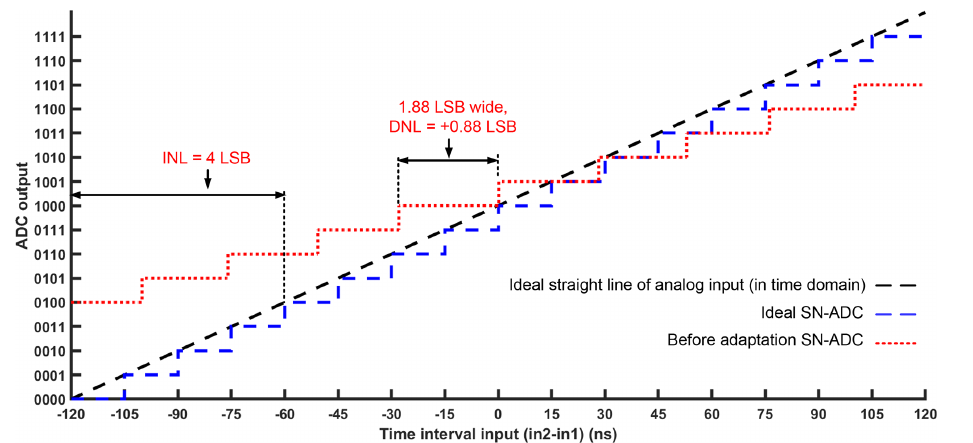
Figure 16. The transfer function of SN-ADC for both ideal and before adaptation at corner no. 5 in Table 3, at the following circuit conditions: V dd is 3V, temperature is 85 ◦ C, and the process corner is the WO (worst-case one). Before adaptation, the SN-ADC parameters NOMC, DNL, and INL are six missing codes, i.e., 0.88 and 4LSB,